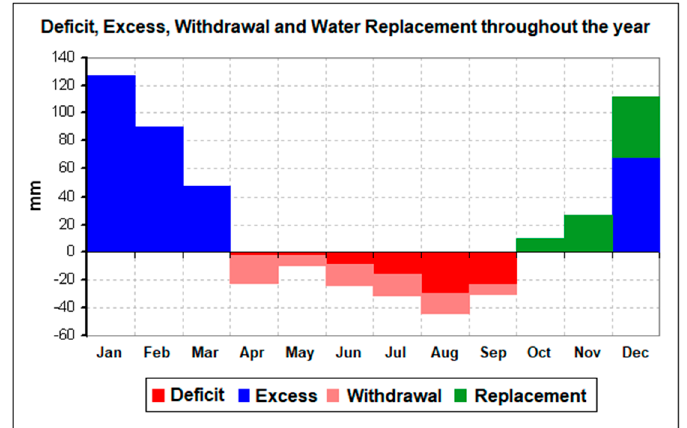
Figure 2. Water balance in the APTA-Pindorama, State of São Paulo, Brazil. Adapted from Brazil’s climate database, available at the Brazilian Agricultural Research Corporation [60].